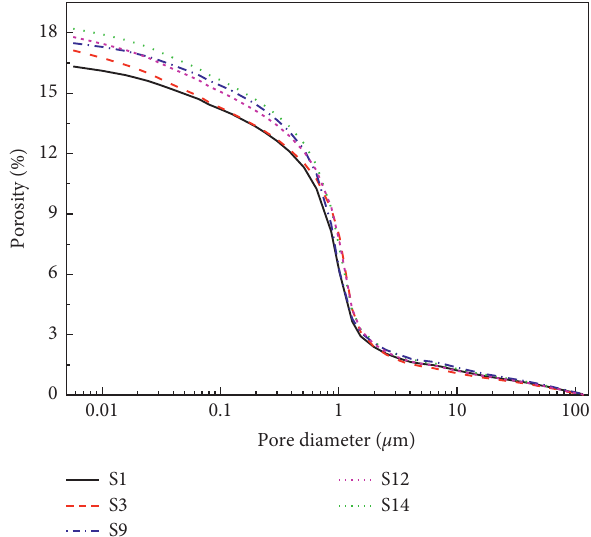
Figure 14: MIP results of hardened waste sediment-based grouting material after curing for 28